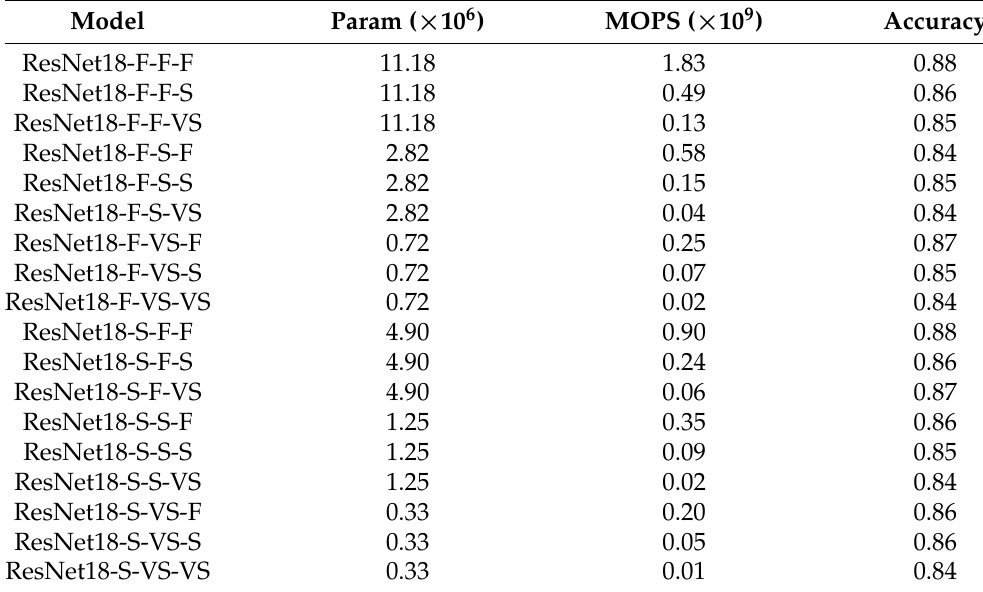
Table 3. Training results for the four network